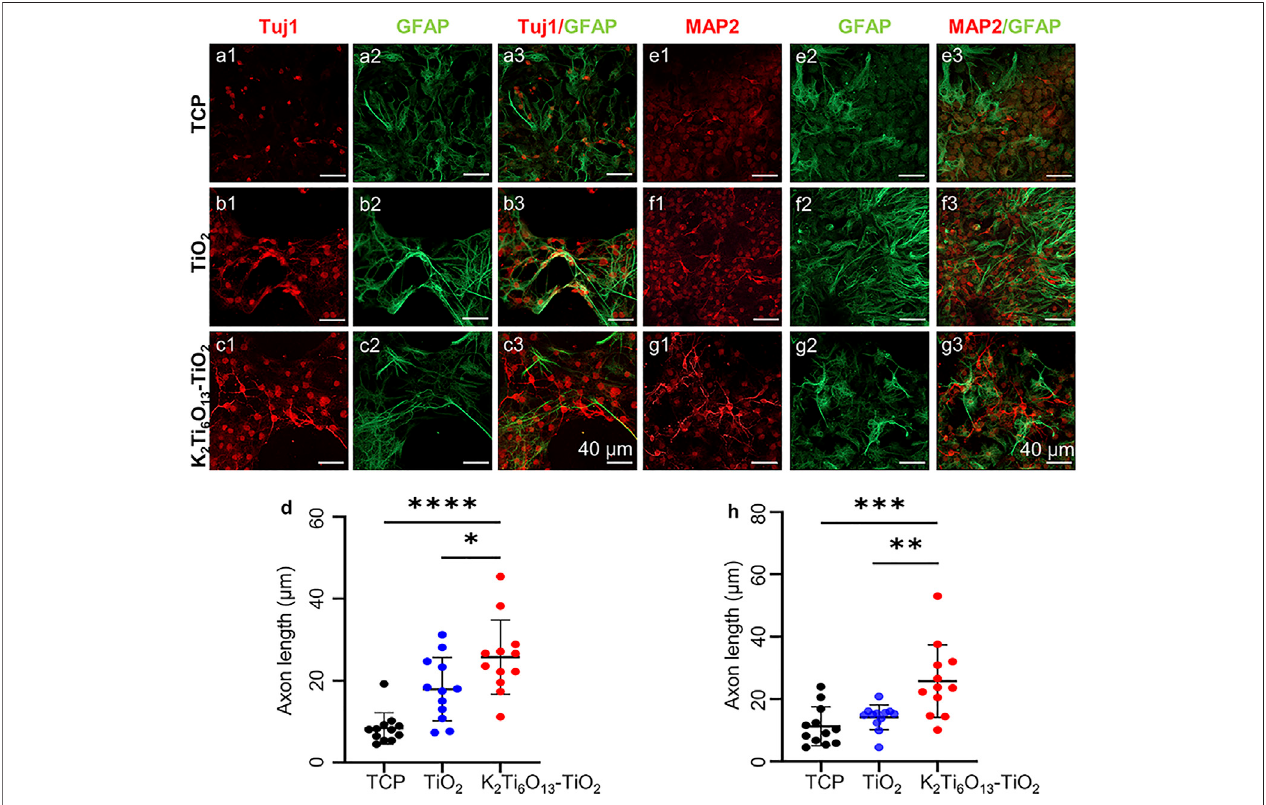
FIGURE6| Immuno fl uorescencecellularstainingimagesofneuralmarkers., (A – C) Immuno fl uorescencecellularstainingimagesofTuj1(red),andGFAP(green)for 7 days (D) Axon length statistics of Tuj1-positive neurons on TCP, TiO 2 nanotube array, and K 2 Ti 6 O 13 -TiO 2 hybrid nanorod array. (E – G) Immuno fl uorescence cellular staining images of MAP2 (red) and GFAP (green) for 7 days. (H) Axon length statistics of MAP2-positive neurons on TCP, the TiO 2 nanotube array, and K 2 Ti 6 O 13 -TiO 2 hybrid nanorod array. * p < .05, ** p < .01, *** p < .001, **** p < .0001 compared with TCP. Data represent the mean ± standard deviation. At least 20 cells were counted. Scale bars in (A – C) and (E – G) are 40 μ